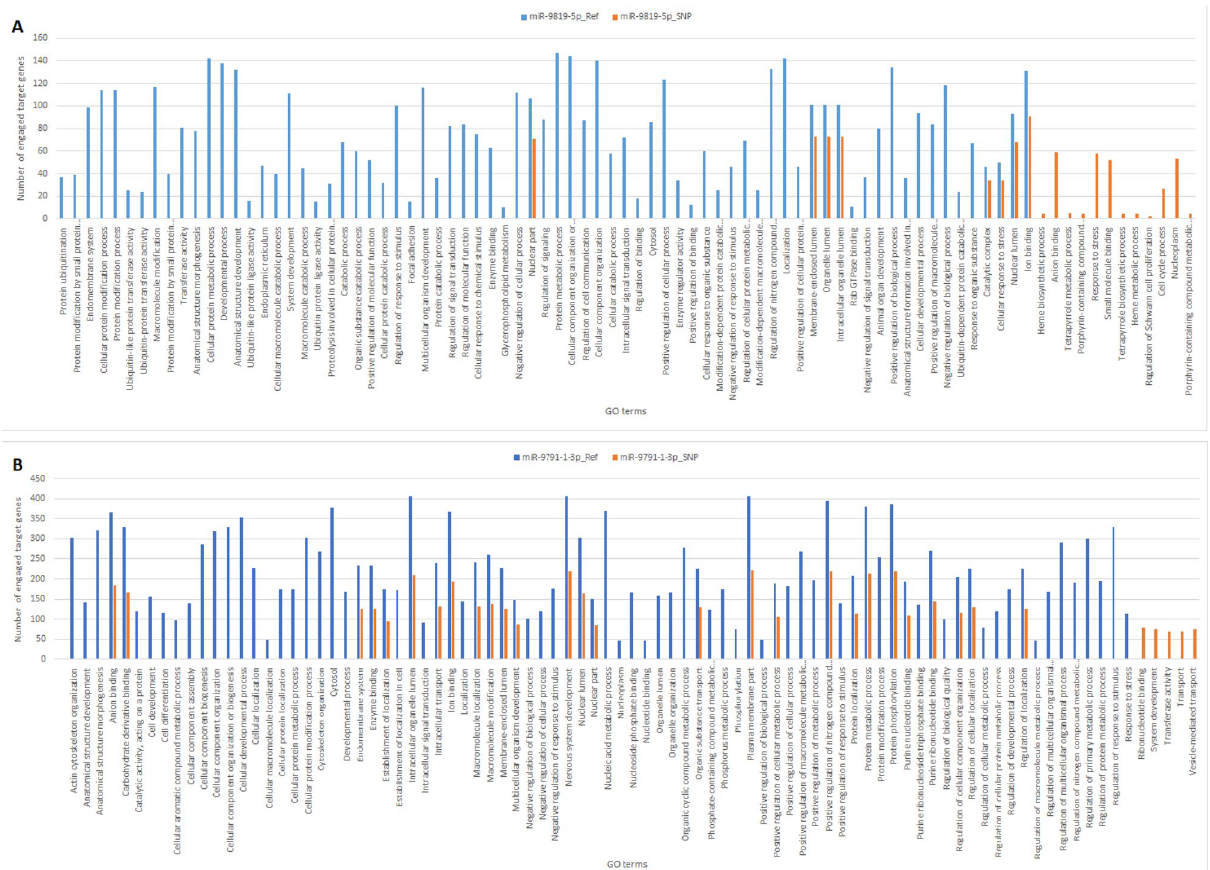
Figure 8. ( A ) statistically significant (p value ≤ 0.05) GO terms enriched in target genes of miR-9819-5p reference sequence (the blue bars) and miR-9819-5p with the SNP (the orange bars); ( B ) statistically significant (p value ≤ 0.06) GO terms enriched in target genes of miR-9791-1-3p reference sequence (the blue bars) and miR-9791-1-3p with the SNP (the orange